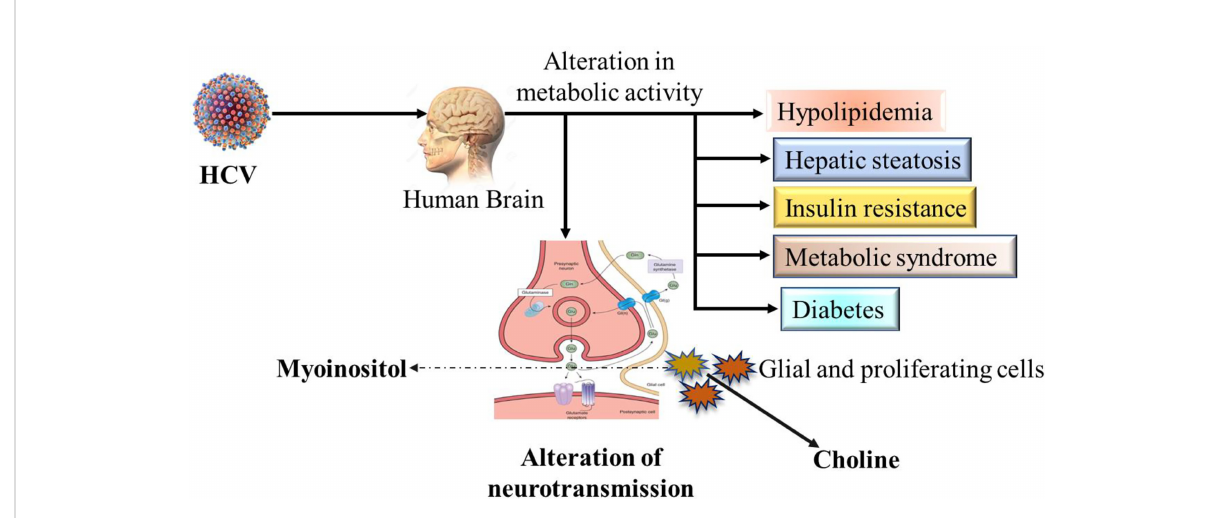
FIGURE 2 Possible schematic overview of neurotransmission alteration and affected metabolic activities by HCV infection in human